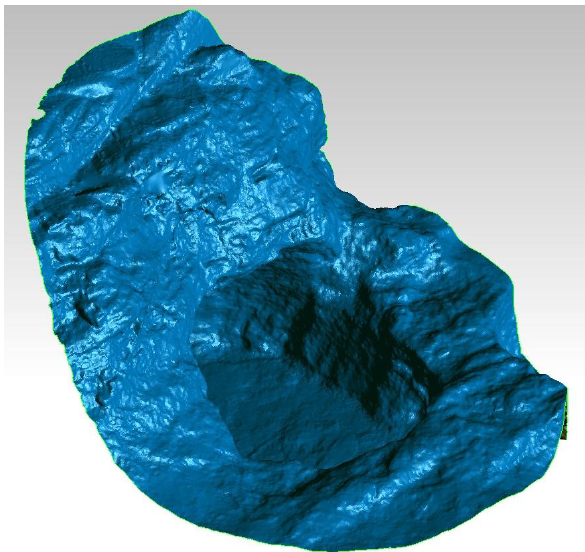
Figure 9. 3-D model of the tomb